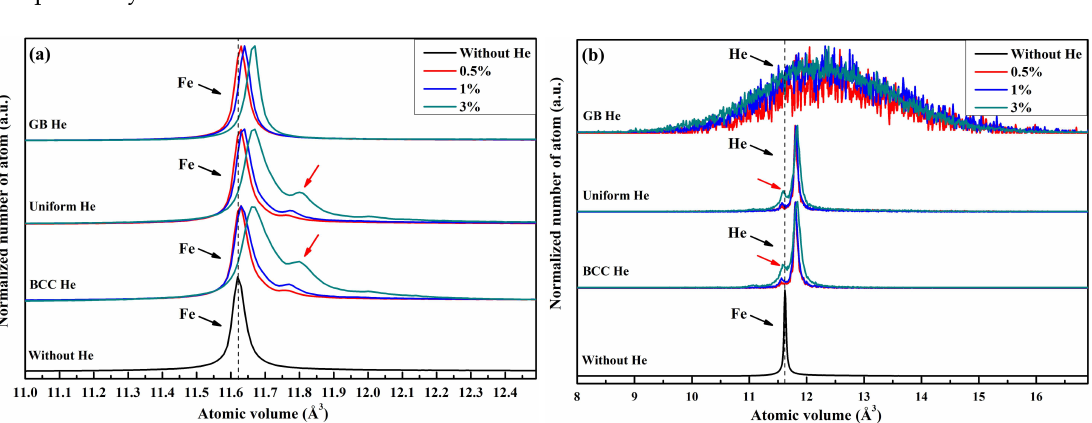
Figure 3. Volume distribution of Fe ( a ) and He ( b ) in polycrystalline model with and without He.